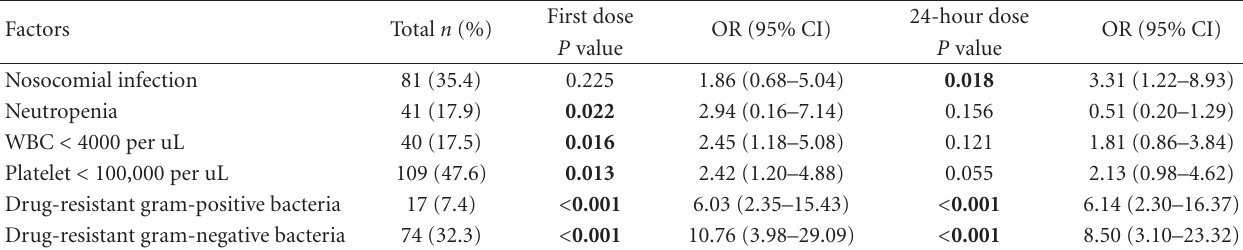
Table 6: Multivariate analysis of factors associated with inappropriate first-dose and 24-hour antimicrobial therapy.